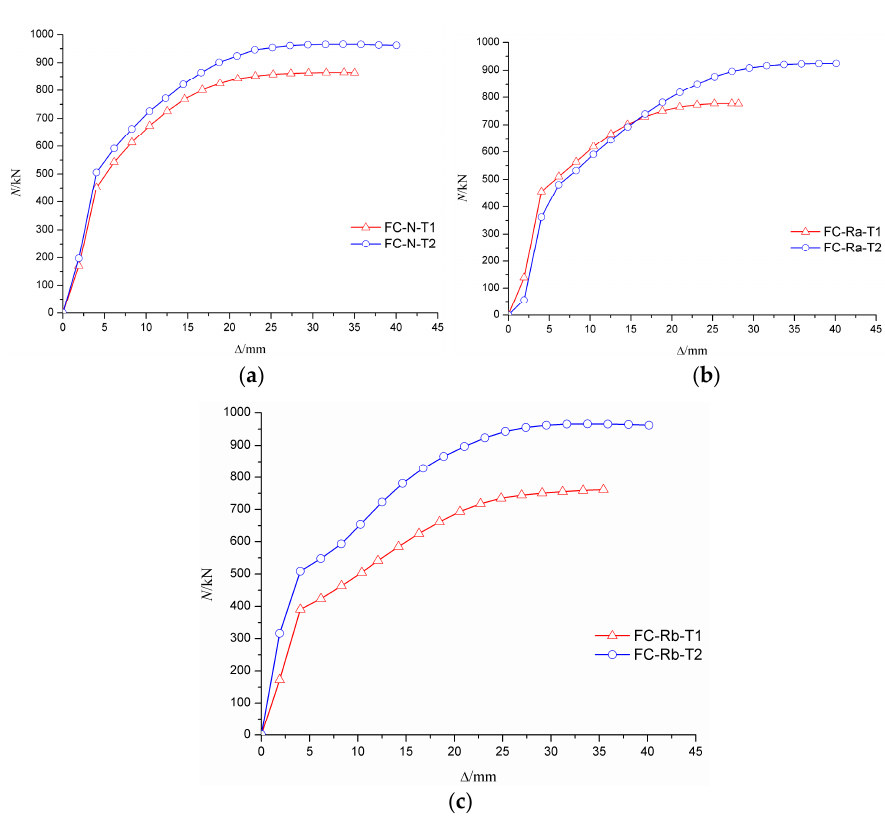
Figure 22. Influence of wall-thickness on N- Δ curves. ( a ) Fine aggregate concrete; ( b ) Recycled aggregate concrete (RP RCA = 100%); ( c ) Recycled aggregate concrete (RP RCA = 100% and RP RFA = 100%).